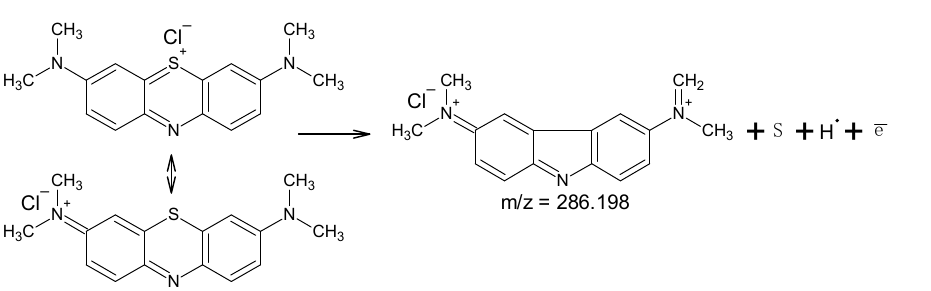
Scheme 4. Destruction of methylene blue under conditions of laser desorption from a DHB matrix. For polymethylene blue under conditions of laser desorption from the DHB matrix, 5.